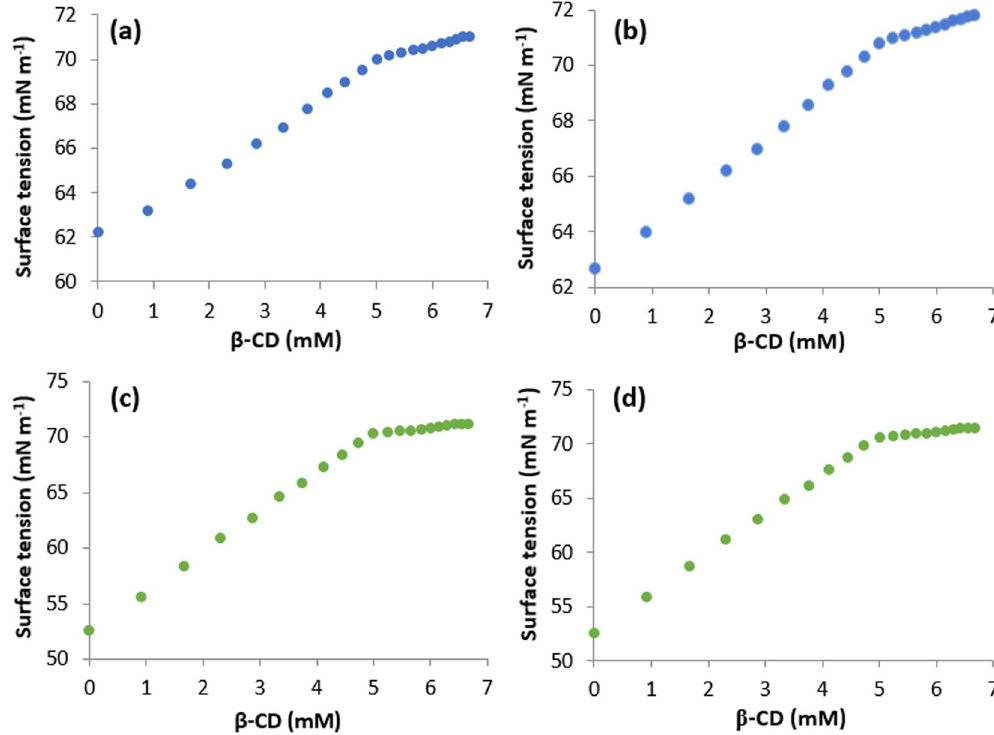
Figure 5. (a , b , c , d) Variations in the surface tension of aqueous SNP with increasing concentration of (a) α -CD, (b) β -CD and the variations in the same of aqueous PEH with increasing concentration of (c) α -CD, (d) β -CD at 298.15 K.